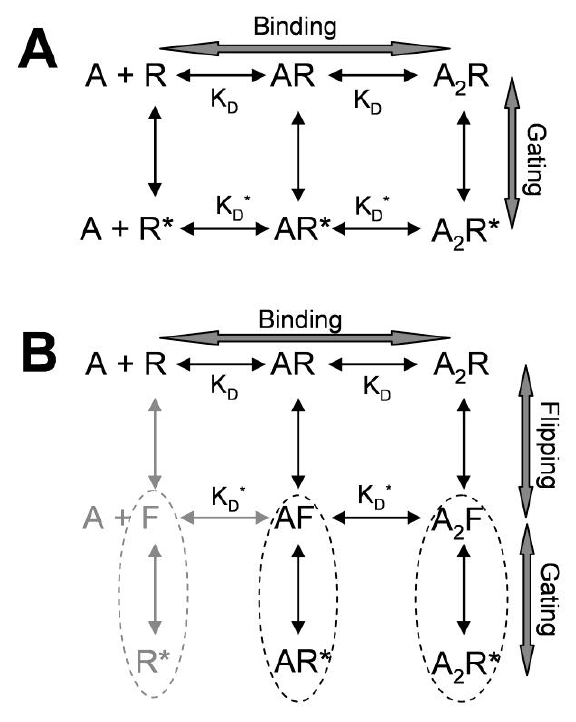
Figure 2. Kinetic schemes for allosteric activation of a typical heteromeric cys-loop receptor. (A) Monod-Wyman-Changeux allosteric activation (MWC) model for allosteric activation [22,33], R, AR, A R are receptors in the resting states with 0, 1 or 2 agonist 2 bound. They have low binding affinity (K ). R*, AR*, A R* are receptors in open states D 2 with high binding affinity (K *) for agonist; (B) Refined MWC model with intermediate D high affinity flip states F, AF, and A F [34]. Flip states are pre-open states with increased 2 affinity for agonists, suggesting a conformational changes in the binding site. Thus, flip and open states in each oval may be considered “activated”